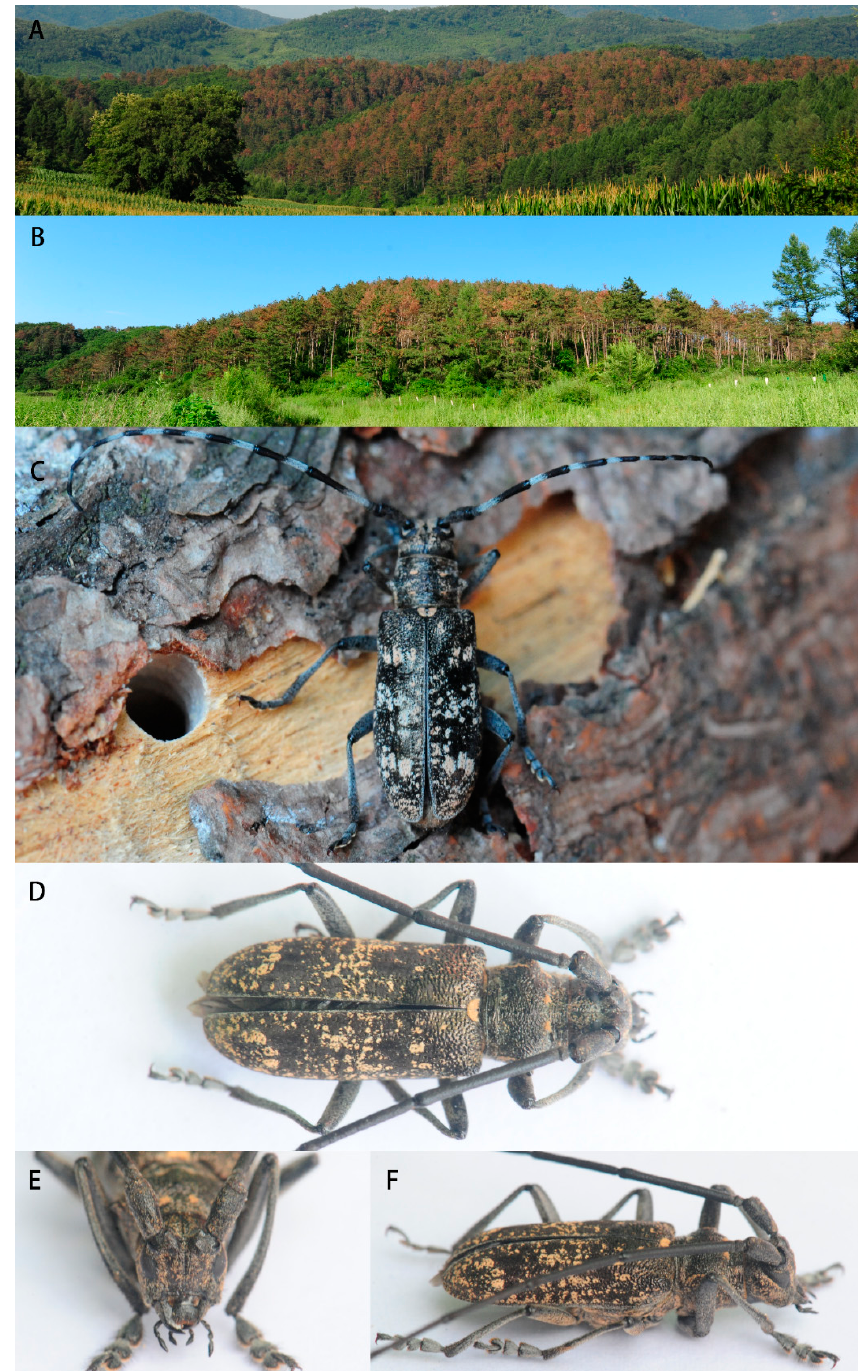
Figure 1. Morphological characteristics of M. saltuarius and affected P. tabuliformis in the field. ( A , B ) P. tabuliformis affected by M. saltuarius and Bursaphelenchus xylophilus in the field; ( C ) female M. saltuarius and emergence hole on P. tabuliformis ; ( D ) the reverse side of male M. saltuarius ; ( E ) the right side of male M. saltuarius ; ( F ) the side face of male M. saltuarius .